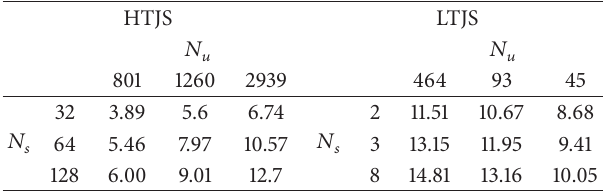
Table 6: Suboptimal WB approach both in the azimuth and in the range dimension: SINR (dB) versus 𝑁 𝑢 and 𝑁 𝑠 for the HTJS and the